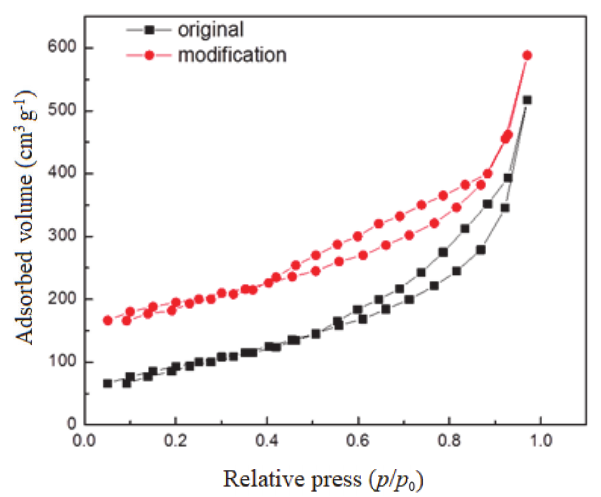
Fig. 2 – N adsorption and desorption isotherms of the mod- 2 ified carrier and the original carrier